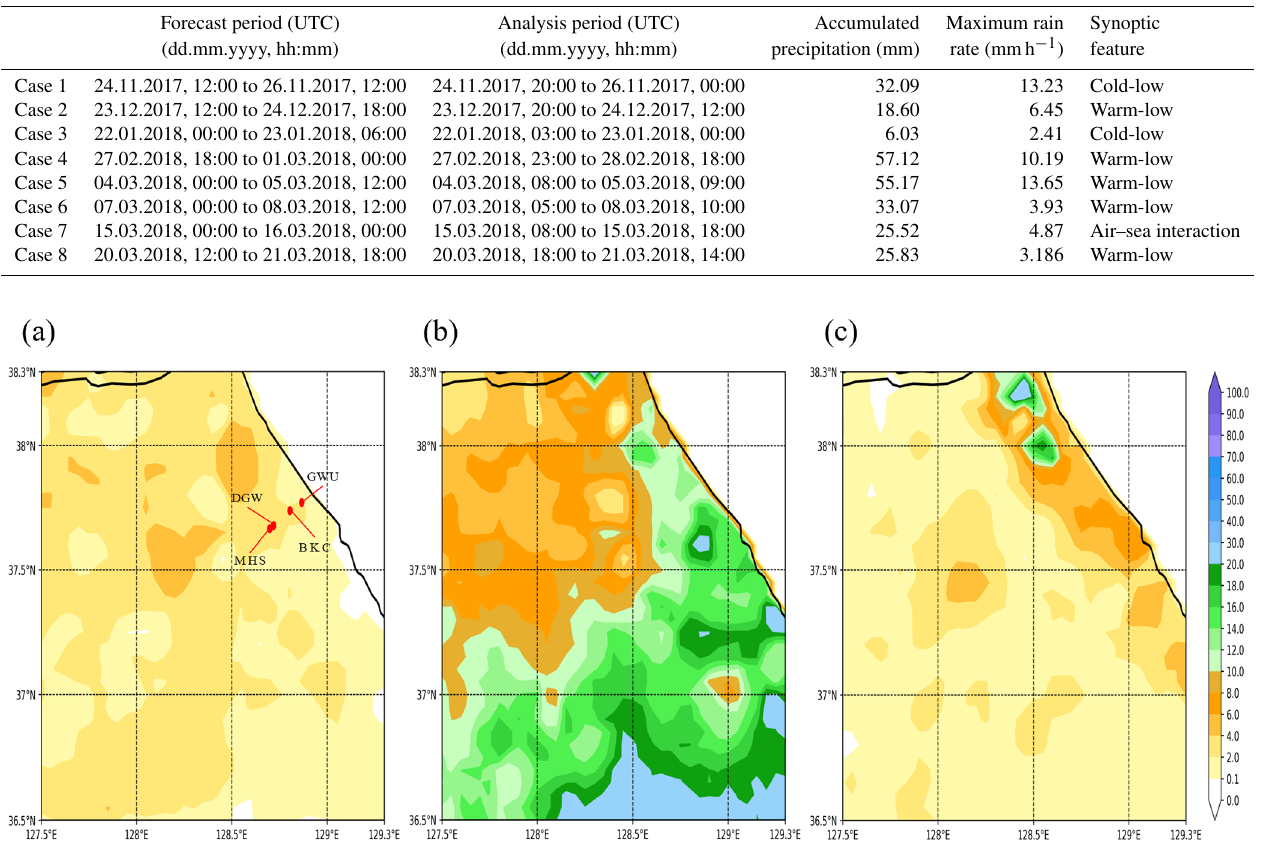
Figure 1. Observed accumulated precipitation amount (mm) (a) for 21h from 22 January, 03:00UTC, to 23 January, 00:00UTC (case 3), (b) for 29h from 7 March, 05:00UTC, to 8 March, 10:00UTC (Case 6), and (c) for 10h from 15 March, 08:00UTC, to 15 March, 18:00UTC (case 7), obtained from the AWS. The locations of one coastal site, Gangneung-Wonju National University (GWU), and three mountain sites, BoKwang 1-ri Community Center (BKC), DaeGwallyeong Regional Weather Office (DGW), and MayHills Supersite (MHS), are noted in (a)